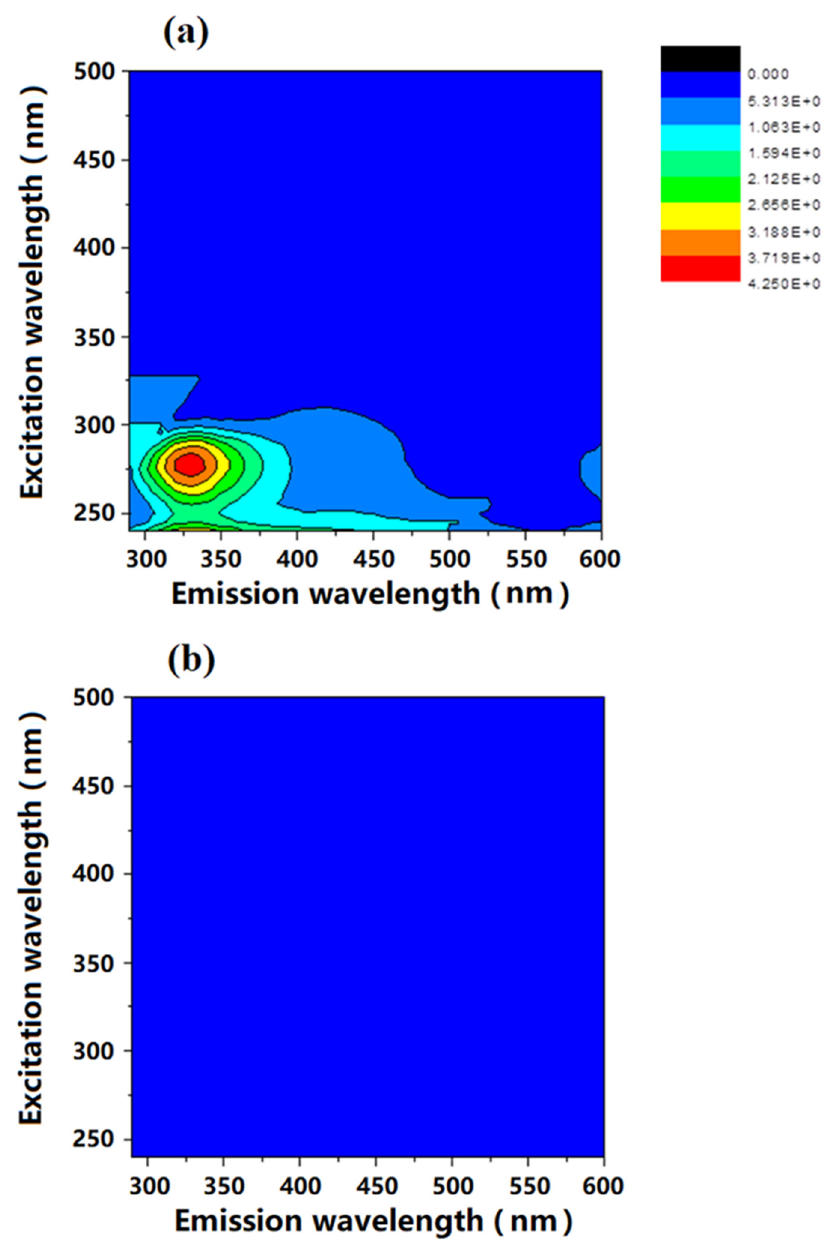
Figure 3. FEEM spectra of wastewater with isolated extracellular polymers from wastewater bacteria Shigella flexneri strain 301 and Escherichia fergusonii ATCC 35469 ( a ), and treated wastewater by the FDFO process ( b ).